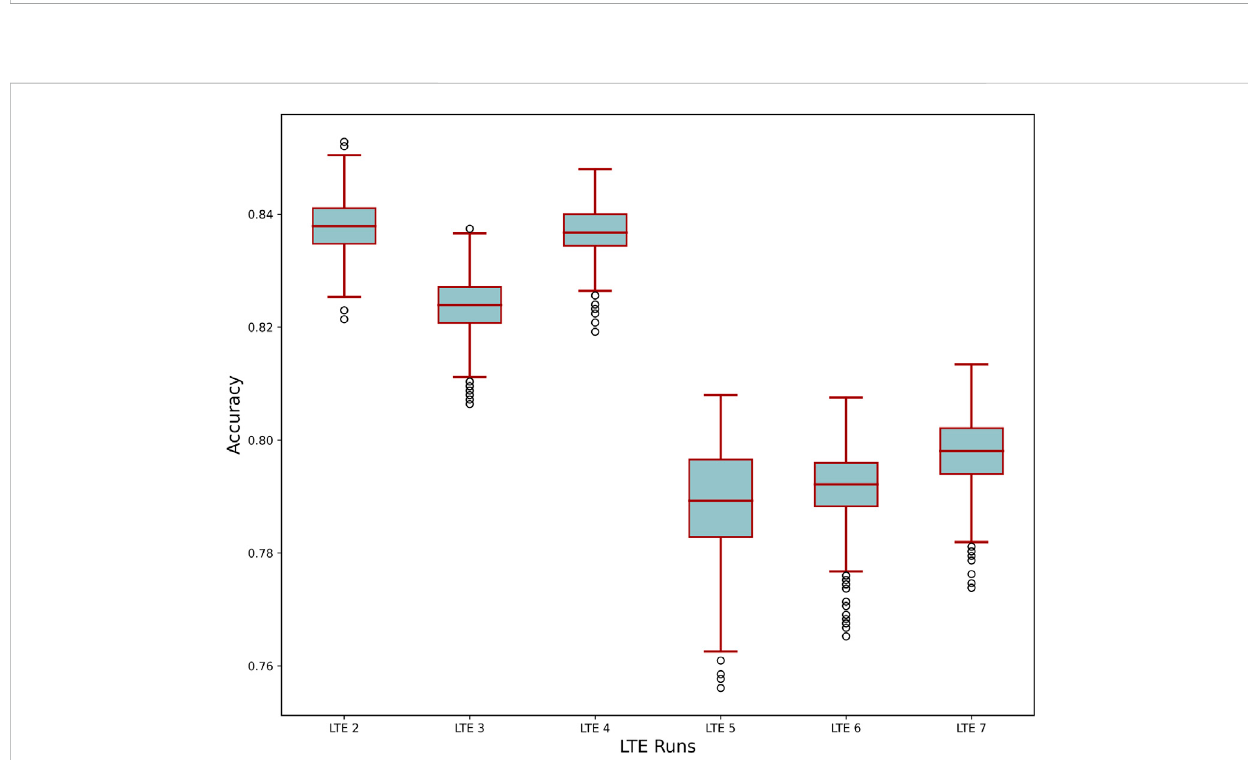
FIGURE 6 Distribution evaluation of the 3,600 model outputs by LTE model sets comparing test